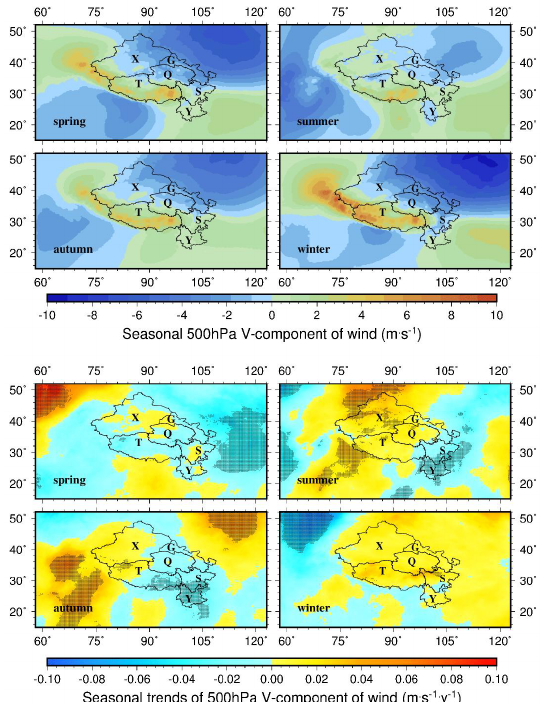
Figure 12. Spatial distributions of the means and trends of V-component wind at 500 hPa (Vcw500) during 1979–2015. Negative values represent southward wind.